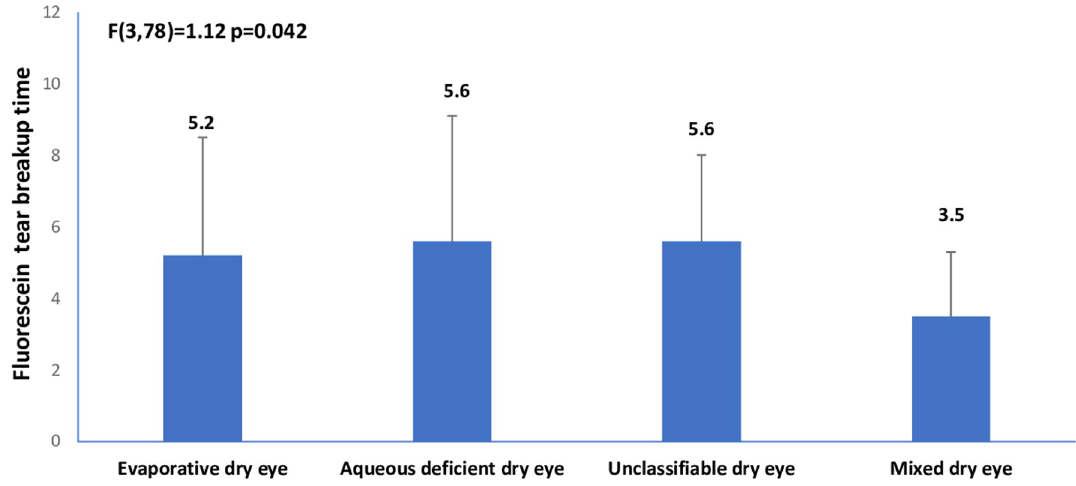
Fig 3. Means of fluorescein tear breakup time across clinical subtypes of dry